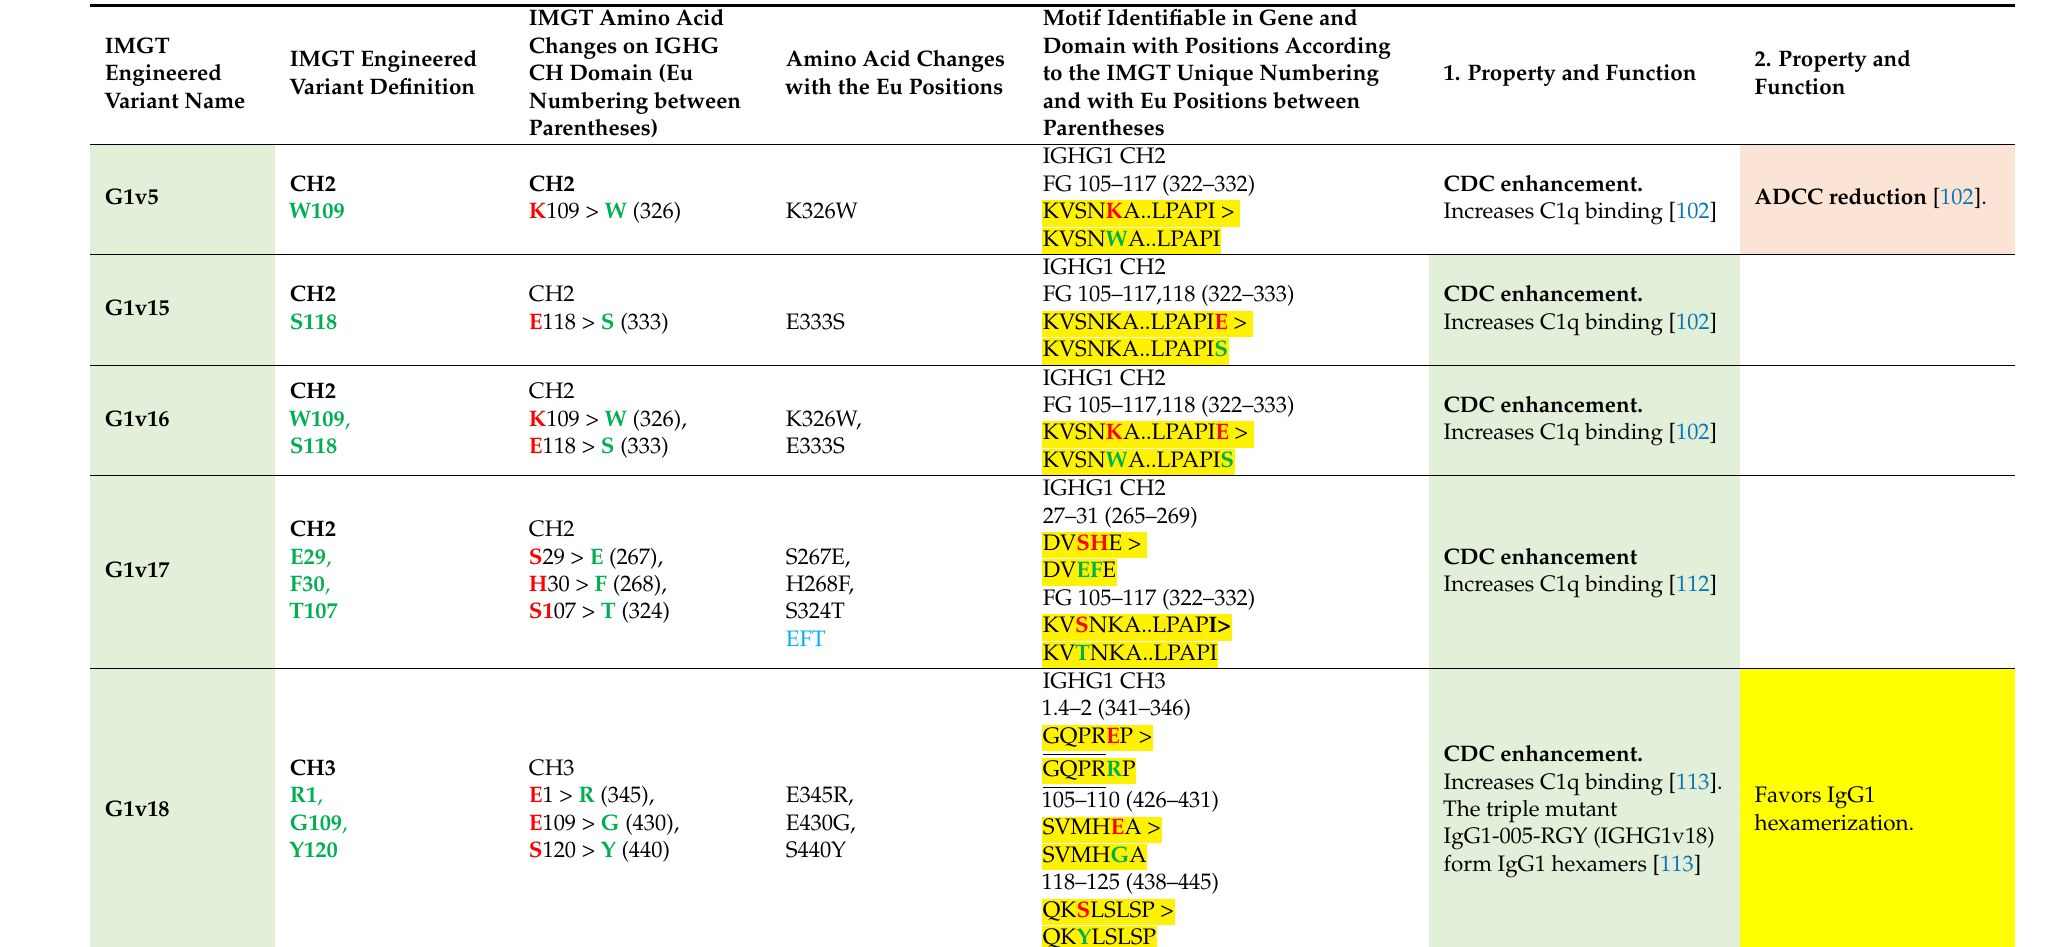
Table 8. IMGT nomenclature, Eu positions and IMGT motif of engineered Fc variants involved in complement-dependent cytotoxicity (CDC) enhancement (Effector